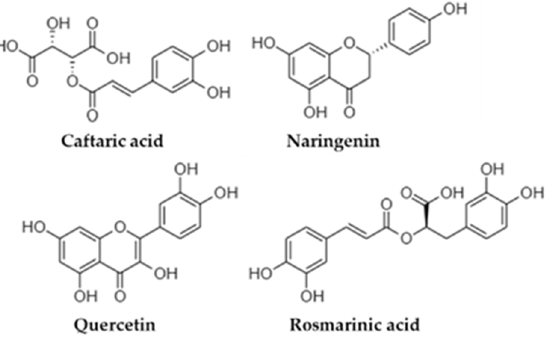
6 of 14 Figure 1. The binding mode of the cocrystallized ligand ({2-[(4-bromobenzyl)carbamoyl]-5- chlorophenoxy}acetic acid-W8X) at the active site of AR (PDB ID: 4LAU). Halogen bonds, hydrogen bonds, and pi–pi interactions are depicted in purple, yellow, and blue dashed lines, respectively. Particularly in the case of the AR enzyme, the criteria for visual inspection include hydrogen bond formation with the amino acids Tyr48, His110, and Trp111. The formation of halogen bonds with Val47 and Thr113, and the existence of pi–pi interactions with